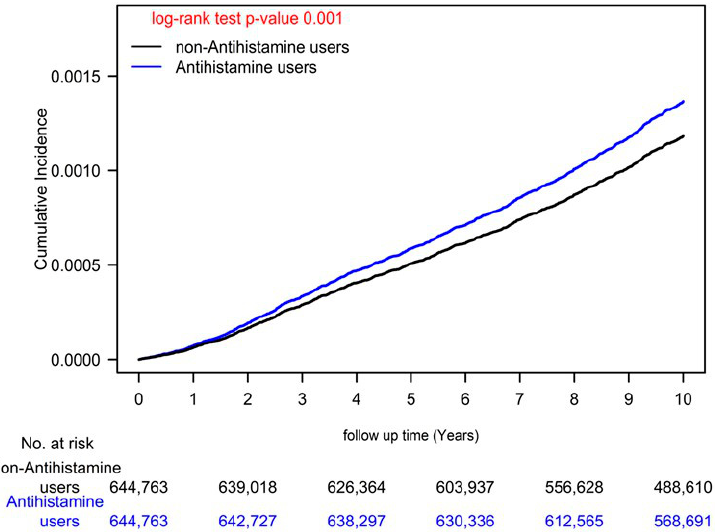
Figure 1. Cumulative incidence of ESCC relative to AH users and nonusers. AH, H1-antihistamine; ESCC, esophageal squamous cell carcinoma.